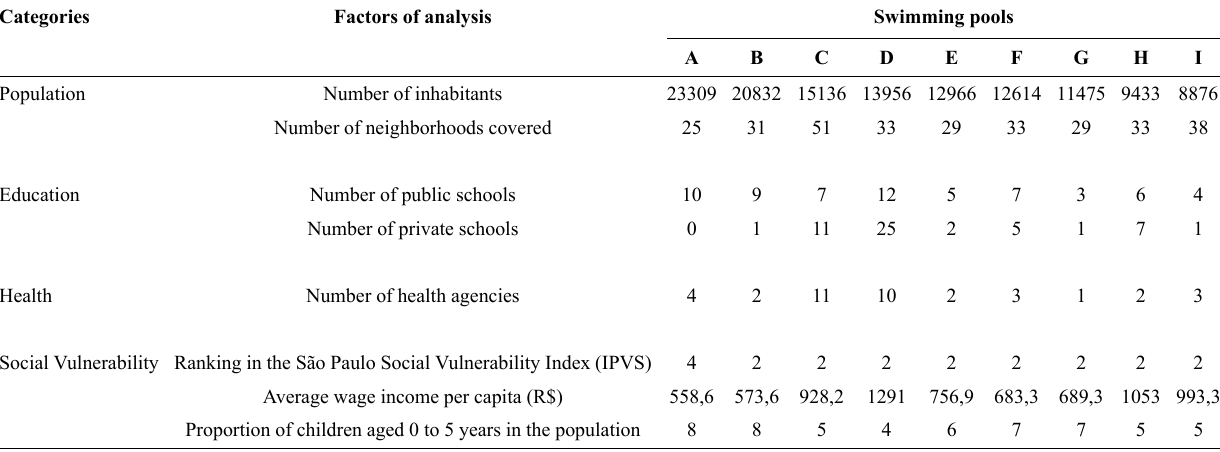
Table 4 - Results of georeferential analysis factors for each pool. Source: own elaboration. Categories Factors of